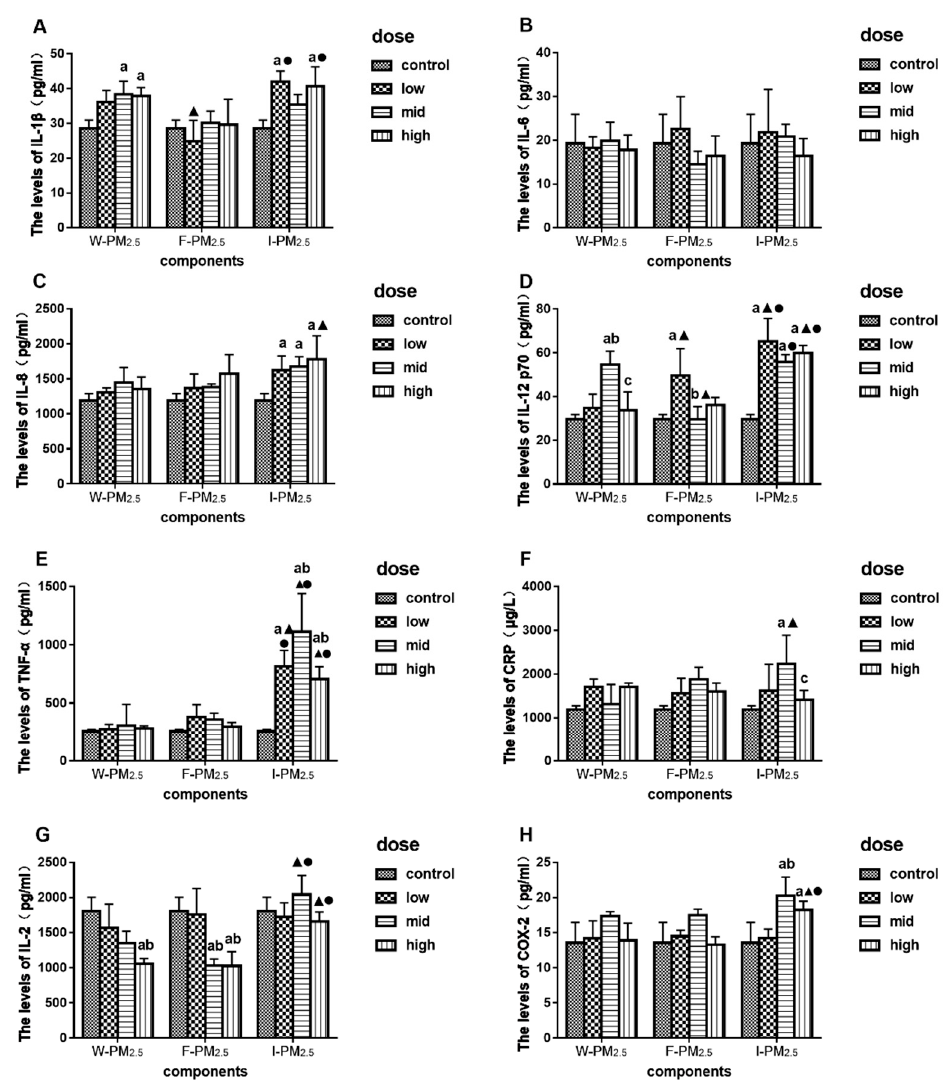
Figure 4. Effects of exposure to PM 2.5 on the levels of IL-1 β ( A ), IL-6 ( B ), IL-8 ( C ), IL-12 p70 ( D ), TNF- α ( E ), CRP ( F ), IL-2 ( G ), and COX-2 ( H ). Data are presented as means ± SD of three independent experiments. a p < 0.05 vs. control group; b p < 0.05 vs. low-dose group; c p < 0.05 vs. mid-dose group; ▲ p < 0.05 vs. W-PM 2.5 at the same dose; ● p < 0.05 vs. F-PM 2.5 at the same dose.